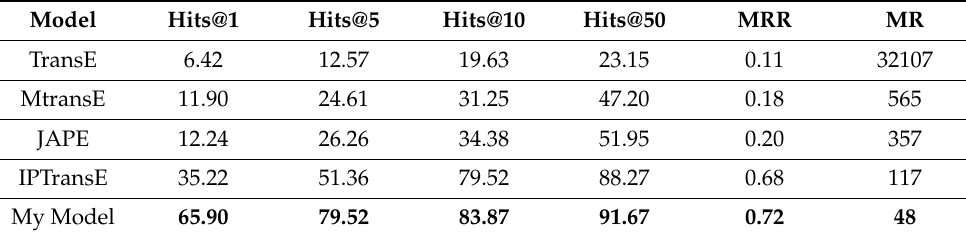
Table 4. EN-DE15K entity alignment